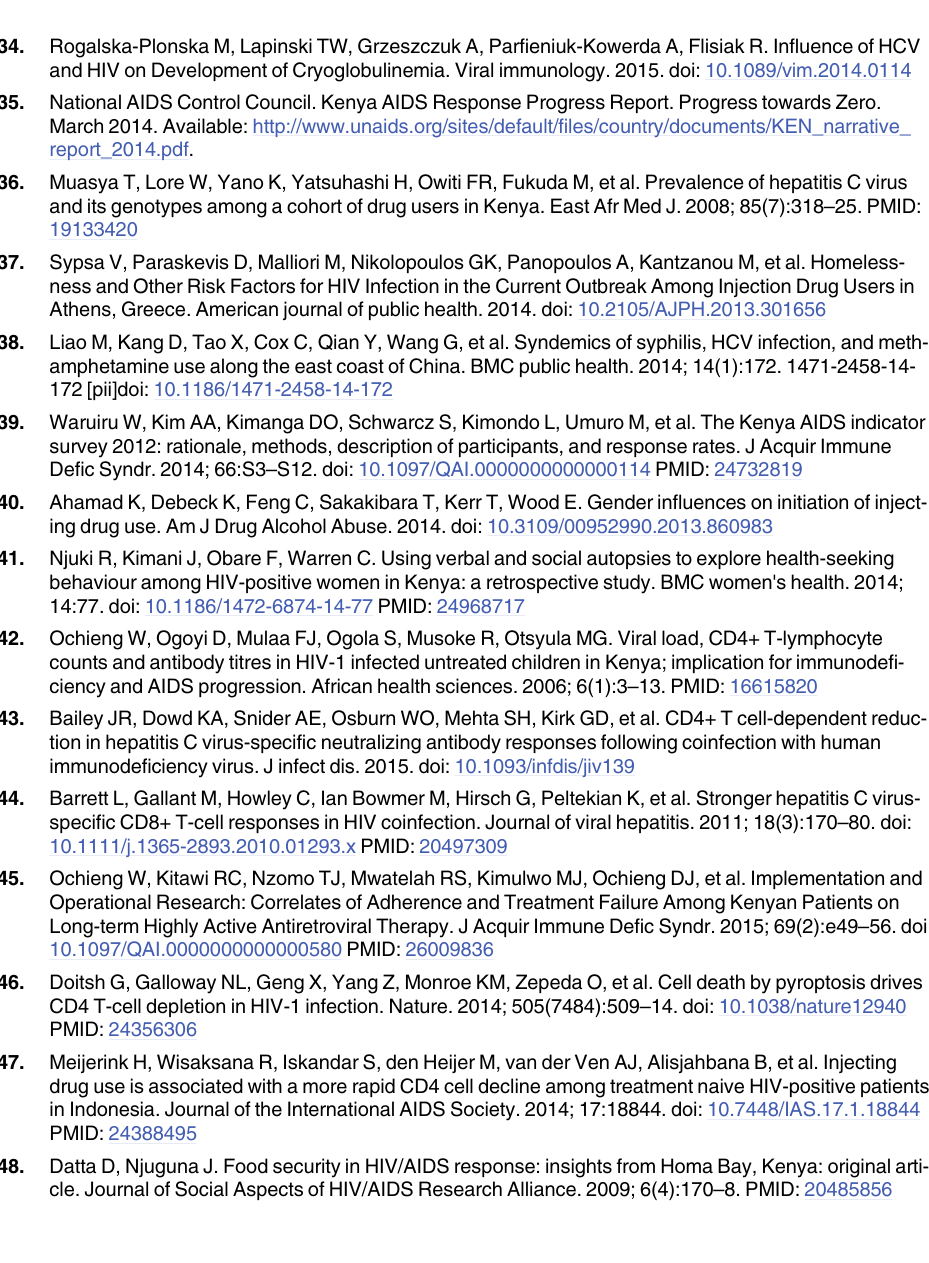
PLOS ONE | DOI:10.1371/journal.pone.0132287 July 24,